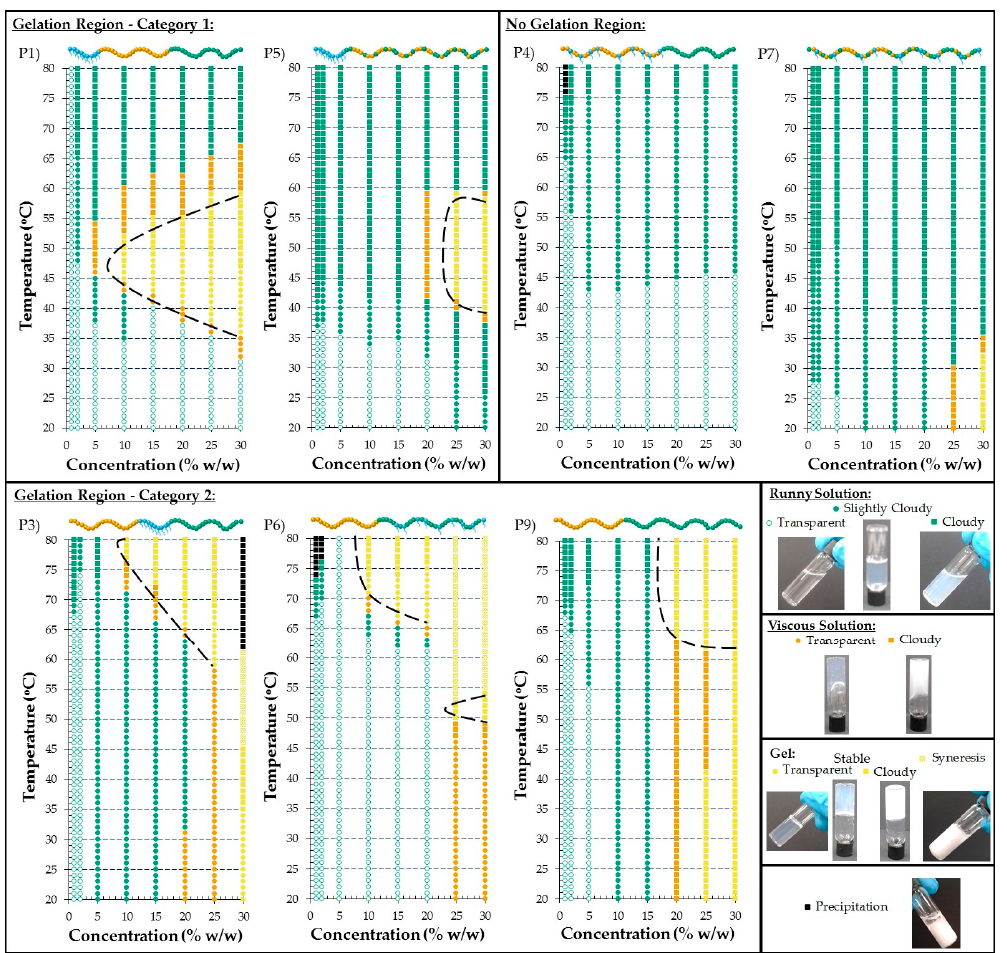
Figure 7. Phase diagrams of the TEGMA-based copolymer solutions in phosphate buffered saline (PBS) of various architectures, namely ABC (Polymer 1), BAC (Polymer 3), (AB)C (Polymer 4), A(BC) (Polymer 5), B(AC) (Polymer 6), and the statistical terpolymer (Polymer 7). The phase diagram of the diblock bipolymer BuMA 20 - b -DMAEMA 34 (Polymer 9) is also shown. The concentrated copolymer solutions in PBS of the ACB (Polymer 2), and the most hydrophobic diblock bipolymer (Polymer 8) were not soluble, thus their phase diagrams are not presented. The transparent and slightly cloudy runny solutions are presented in white and green circles, respectively, whereas the cloudy ones are indicated by green squares. The transparent and cloudy viscous solutions are shown in orange circles and squares, respectively. The transparent and cloudy stable gels are indicated by yellow circles and squares, respectively. Gel syneresis is represented by white squares with diagonal yellow lines, while the precipitation is shown in black squares. The gelation region is approximately shown with the black dashed line. The corresponding polymer structures are schematically given, in which the TEGMA, BuMA, and DMAEMA units are colored in blue, orange, and green, The phase diagrams which include a gelation region can be divided into two categories, which differ in the thermoresponsive behavior; as is shown in Figure 7. In the first category, two copolymers are included, specifically Polymers 1 and 5, whereas Polymers 3, 6, and 9 belong to the second category. When copolymer solutions of the first category are concerned, runny solutions are formed at low temperatures, regardless of the increased concentrations. These solutions form a